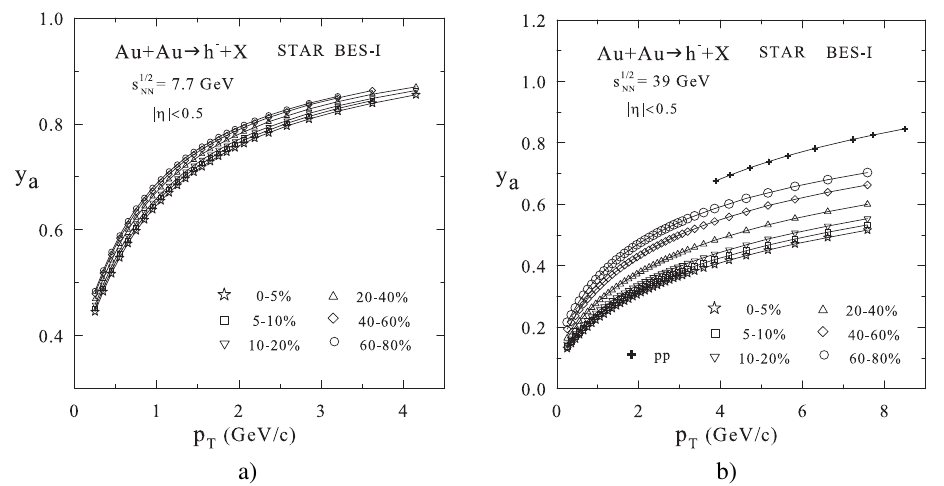
Figure 4. The dependence of the fraction y a on the transverse momentum p T of h − hadron produced in √ Au + Au collisions at the energy s NN = 7 . 7 (a) and 39 GeV (b) for di ff erent centralities and | η | < 0 . 5.